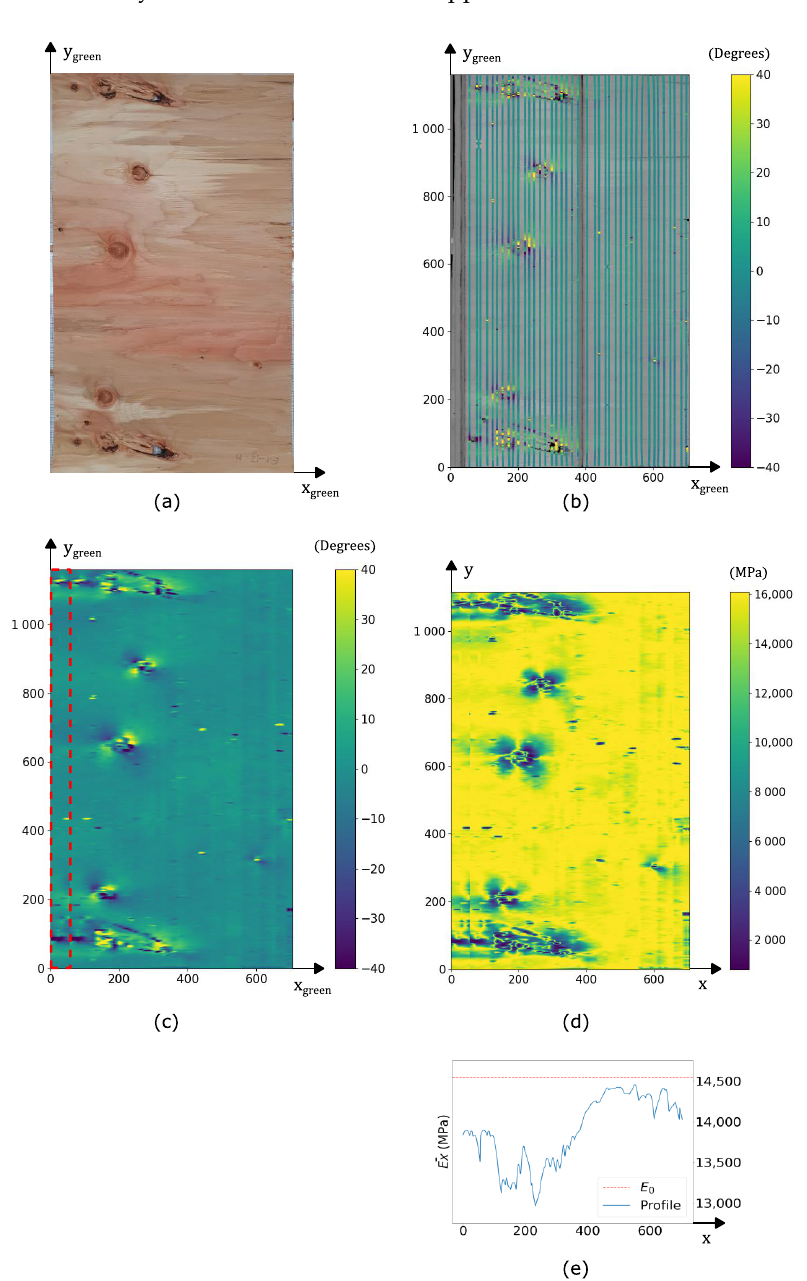
Figure 3. The veneer to fiber orientation grid: ( a ) veneer picture using a photo camera, ( b ) grayscale image and fiber orientation laser points, ( c ) interpolated local fiber orientation grid, ( d ) local elastic modulus grid, ( e ) stiffness profile.